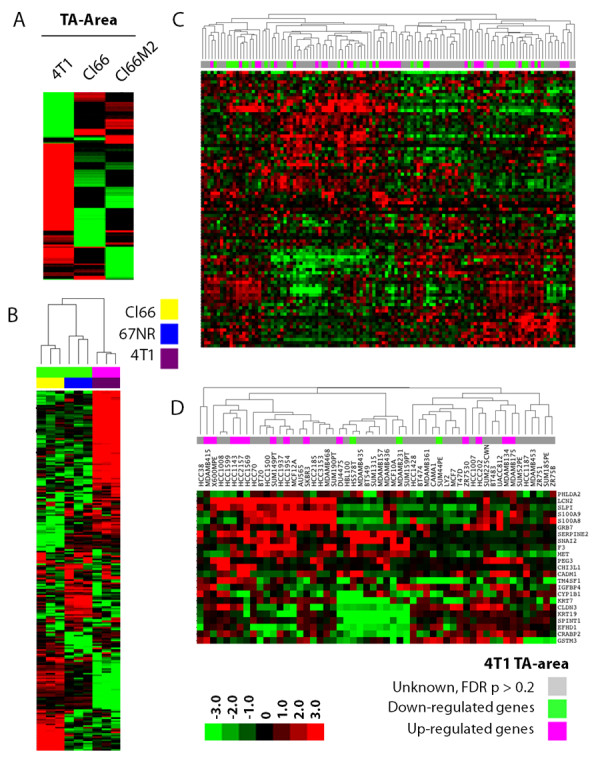
The TA area resembles matched primary tumors, human breast tumors and cancer cell lines. A. Hierarchical clustering of median centered gene expression from the TA area of the three cell lines (4T1, Cl66 and Cl66M2). B. The gene expression profile of primary syngeneic tumors derived using the 4T1, CI66 and 67NR mouse cell lines [23] resembled the TA area in our osteolytic breast cancer model as predicted by NTP algorithm (FDR < 0.2). Primary tumor samples and prediction significance (FDR < 0.2) are color coded and displayed at the top of the hierarchical cluster. C. The gene expression profile of primary human breast tumors [25] and D. human breast cancer cell lines resembled the TA area of either the 4T1 (up-regulated genes from 4T1 TA area, top bar in pink) or Cl66 (down-regulated genes from 4T1 TA area, top bar in green) of the osteolytic breast cancer model as predicted by NTP algorithm. Prediction significance (FDR < 0.2) for each sample is shown in the colored bar on the top of the hierarchical cluster. Samples predicted with FDR p > 0.2 do not resemble either the TA area or the TB interface.